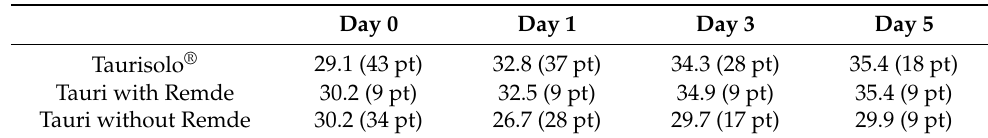
Figure 2. Inflammatory parameters at the admission and at day seven after treatment. Virological data, measured by evaluation of Ct from baseline to day 5, showed a faster decreasing trend, although not enough to reach statistical significance (Table 5). At T0 (baseline), the mean of C (t) was 29.1 with a sample of 45 patients. At T1 (day 1), the mean of C (t) reached 32.8, with a sample of 37 patients. At T2 (day 3), the mean of C (t) reached 34.3 with a sample of 28 patients. At T3 (day 5), the mean of C (t) was 35.4 with a sample of 18 patients. We found that in all patients, independently from remdesivir therapy, there was a faster increase in C (t) within a few days—this correlates with a more rapid negativization of the patient and, therefore, with lower contagiousness. Table 5. Viral charge expressed in c (t) in patients treated with Taurisolo ® at baseline and days of treatment.